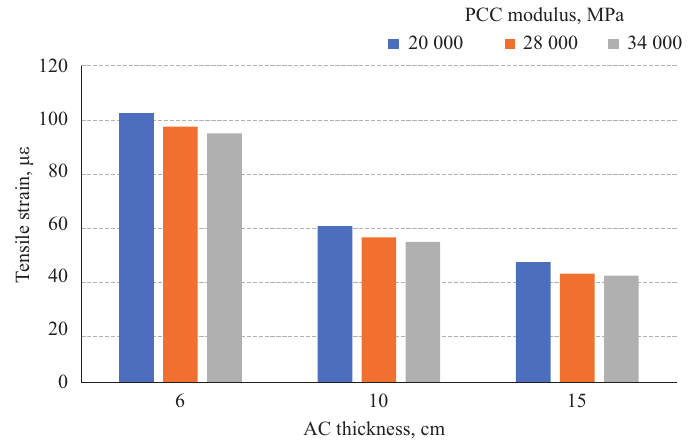
Figure 9. Longitudinal tensile strain variation for bonded